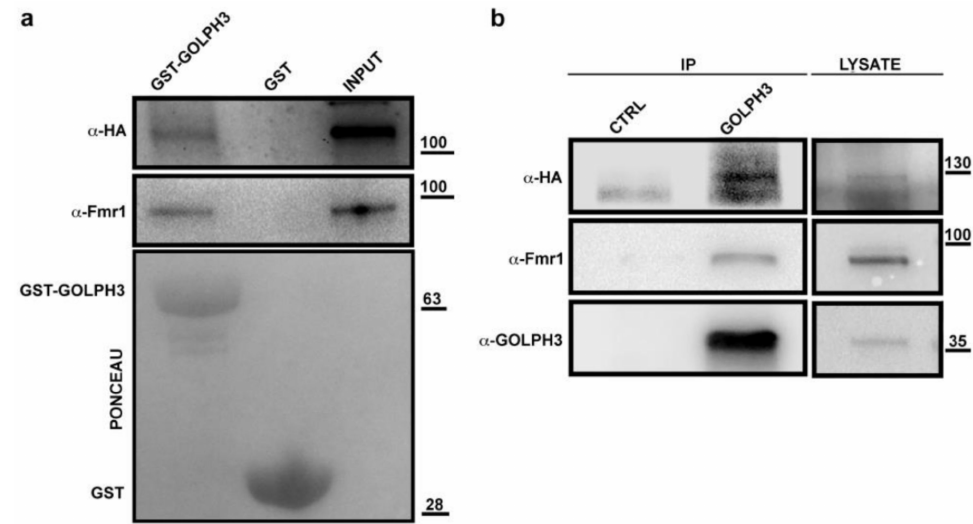
Figure 6. dGOLPH3 interacts with dAtx2 and dFmr1. ( a ) Bacterially expressed GST-dGOLPH3 and GST (control) were purified by Gluthatione-Sepharose beads and incubated with testis ex- tracts expressing dAtx2-HA. Ponceau staining is shown as a loading control. A percentage of 2% of the input and 25% of pull-downs were loaded and probed with the indicated antibody. Molecular mass is expressed in kilodaltons. ( b ) Protein extracts from testes expressing dAtx2- HA were immunoprecipitated with antibodies against Drosophila GOLPH3 (rabbit G49139/77) and blotted with mouse anti-dGOLPH3 S11047/1/56, mouse anti-dFmr1, or mouse anti-HA. Pre-immune serum (G49139/1, from the same animal before the immunization) was used in control experiments (CTRL). Molecular mass is expressed in